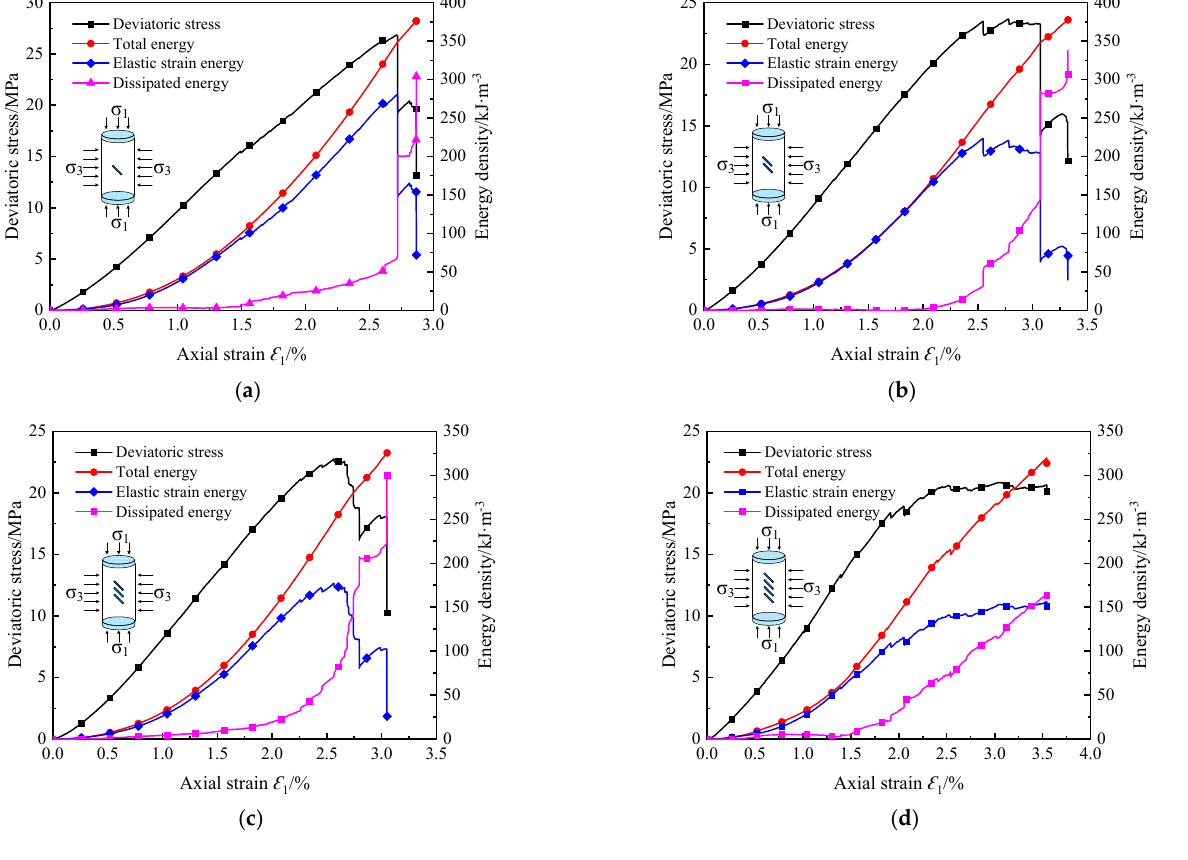
Figure 14. Energy evolution of coal specimens with different numbers of prefabricated cracks under confining pressure 3 MPa with axial strain. ( a ) Coal specimen M − 3 − 1; ( b ) Coal specimen M − 3 − 2; ( c ) Coal specimen M − 3 − 3; ( d ) Coal specimen M − 3 − 4.